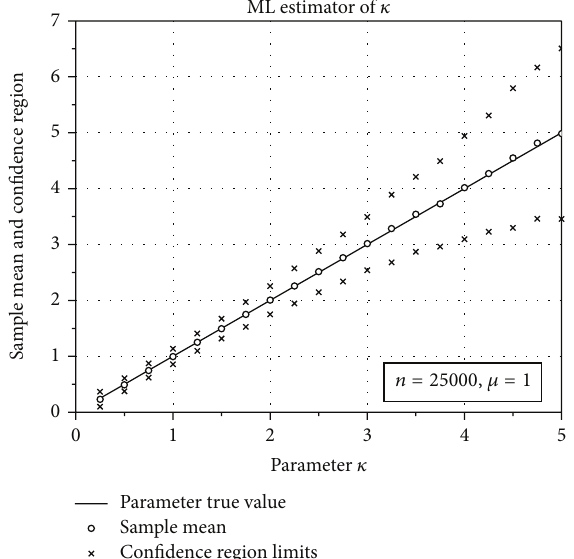
Figure 8: Sample mean and confidence region ( ±2 × sample stan- , for 𝑛 = 25000 and 𝜅 = 2 . dard deviation) of ̂𝜇 ML